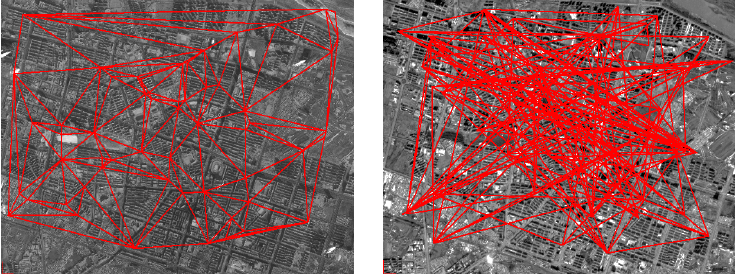
Figure 15. The initial corresponding triangulations produced by TAACC. The false triangle constraints cause mismatches as shown in Figure